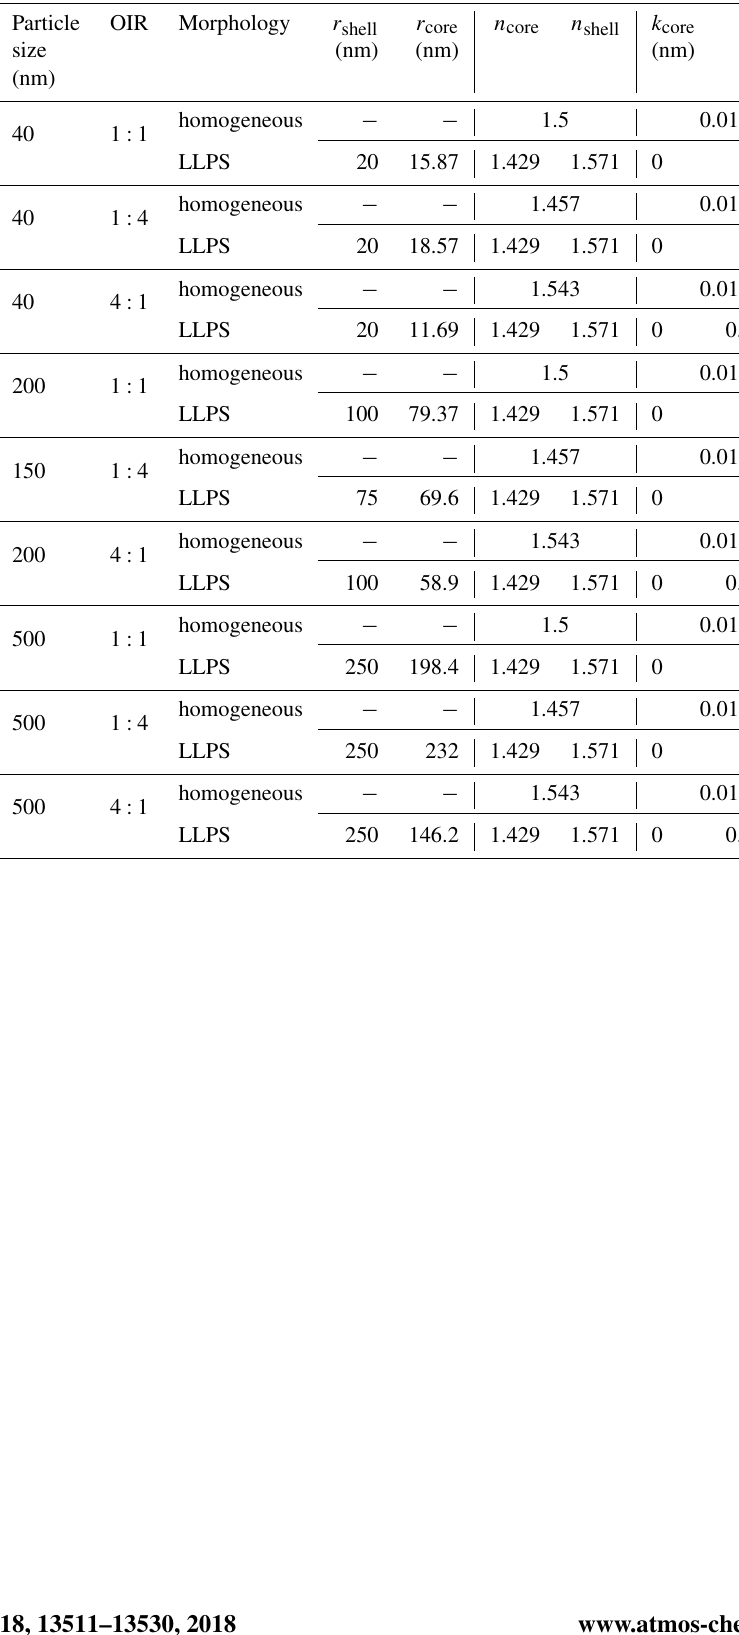
Table A2. Calculated values for relative size of the core to the shell for phase-separated particles and refractive indices ( k = 0 . 01) for homogenous and LLPS cases at different sizes and OIRs using volume